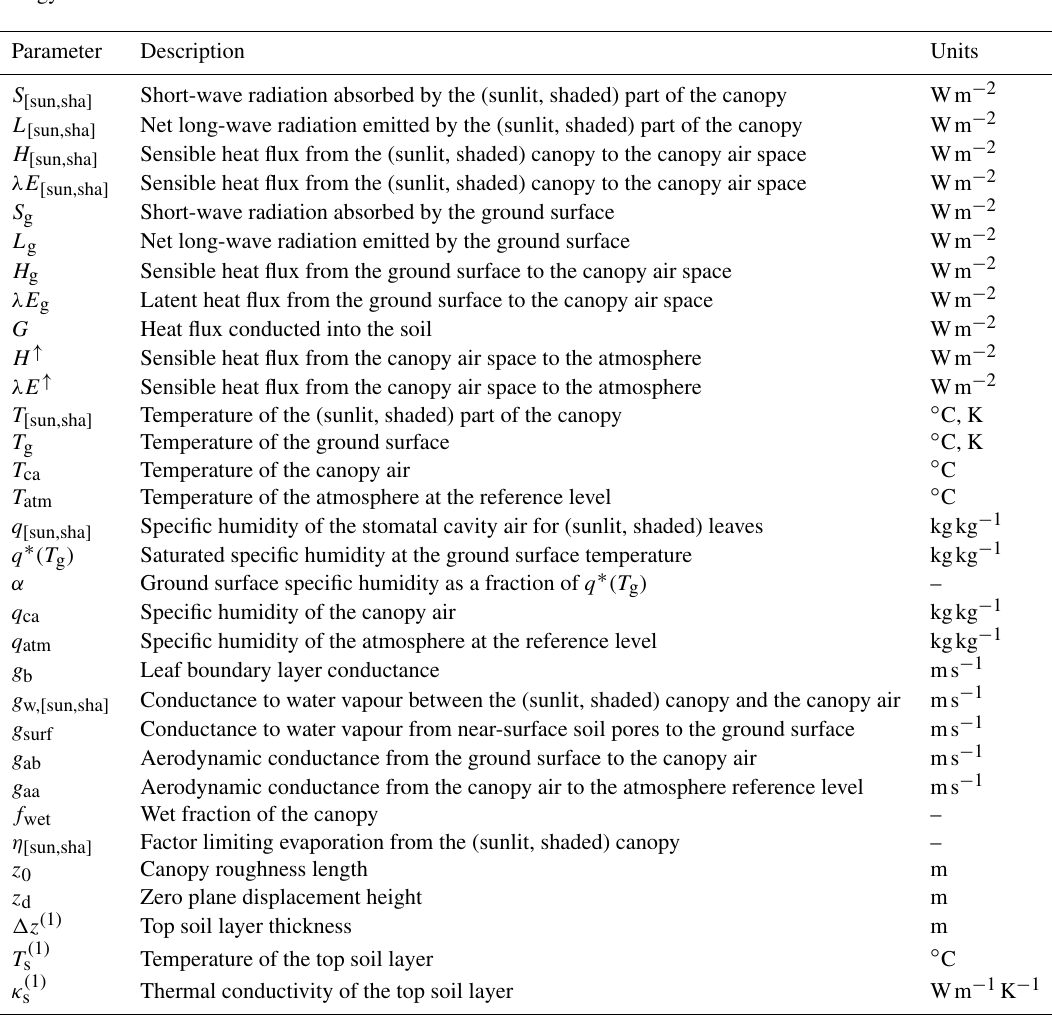
Table B2. Energy